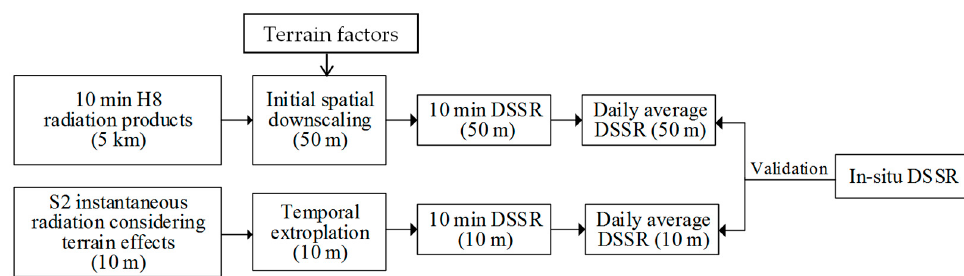
Figure 2. Flowchart of the daily average DSSR estimation.